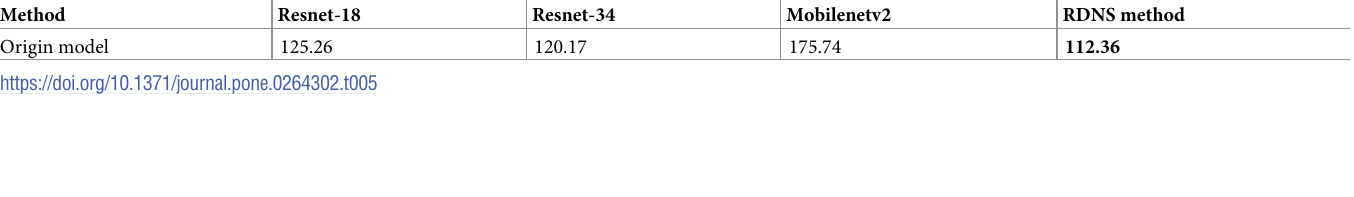
Table 5. The performance of our method in 3D pose estimation. The data in the table is the mean error per joint position (MPJPE). The better results in our method are written in bold. No action is distinguished in the table. The unit of MPJPE is mm .